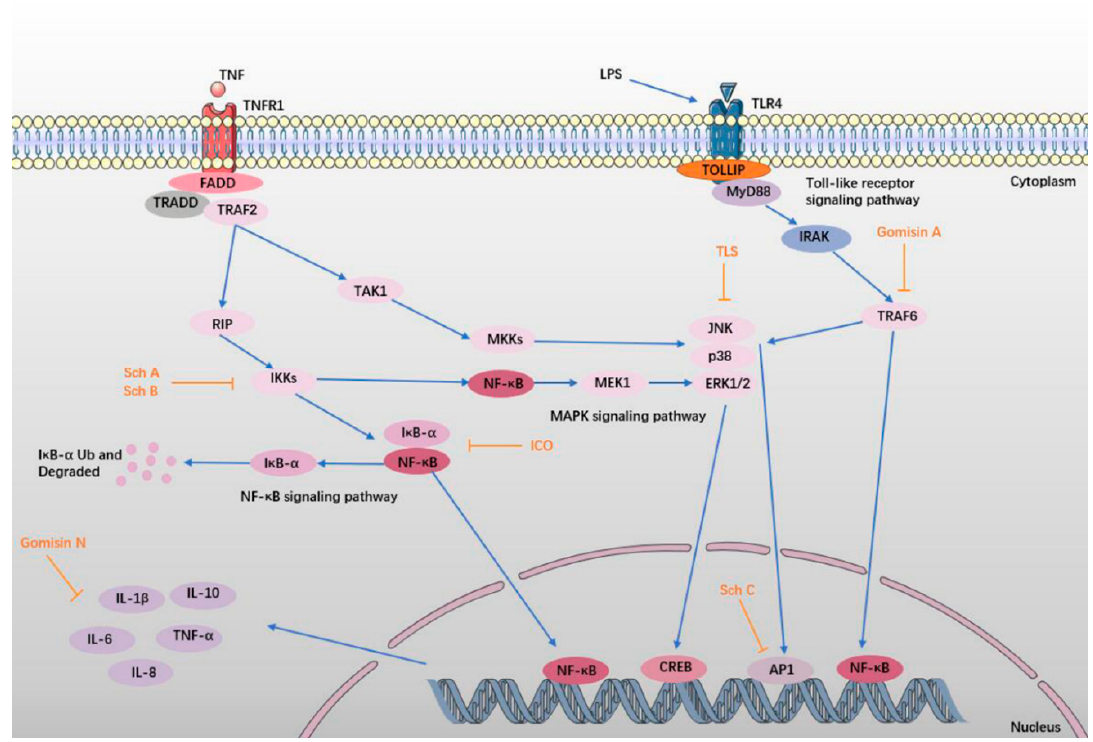
Figure 4. SCF and its active ingredients protect against inflammation in NDs. In the inflammatory response, TLR4 recognizes lipopolysaccharide (LPS), and then binds to the MyD88 Toll structure, forming a TLR-MyD active complex. Then, the complex recruits and activates the IL-1 receptor-associated kinase (IRAK), which is associated with tumor necrosis factor-associated factor 6 (TRAF6), activating the downstream mitogen-activated protein kinases (MAPK) pathway [101,102]. Meanwhile, TNFR1 binds to TNF, and interacts with receptor-interacting protein (RIP), activating the downstream inhibitory kappa B kinase (IKK) and MAPK pathway [103,104]. Phosphorylation of I κ B protein leads to degradation of the protein, promotes nuclear translocation of nuclear factor- κ B (NF- κ B), and transfers NF- κ B to the nucleus [105]. At the same time, the activation of the MAPK pathway leads to the production of activator protein-1 (AP-1), which is phosphorylated, and then enters the nucleus. Activation of NF- κ B and AP-1 can lead to over-expression of the inflammatory factors, such as TNF- α , IL-1 β , IL-6, IL-8, and IL-10, resulting a series of inflammatory reactions [106–109]. The protective effect of SCF and its active ingredients are shown in orange. of SCF and its active ingredients are shown in